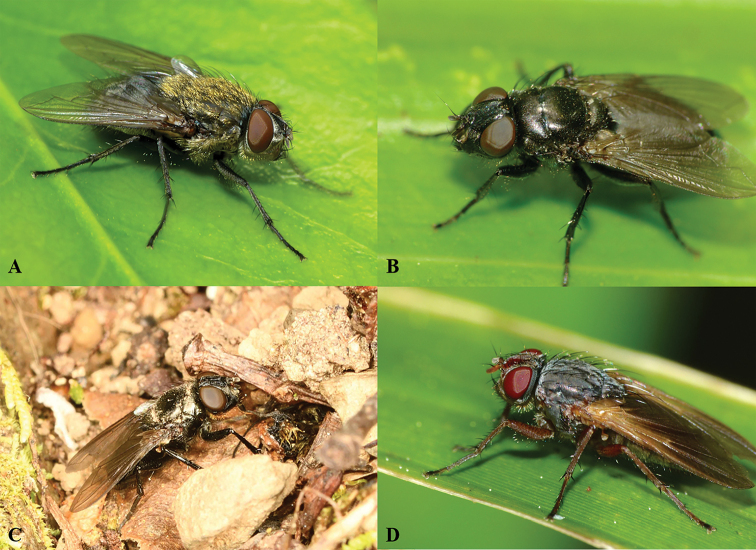
Diversity of the genus Pollenia. APollenia
pediculata Macquart [New Zealand] BPollenia
pernix (Hutton) [New Zealand] CPollenia
nr.
pernix [New Zealand] DPollenia
uniseta Dear [New Zealand]. Photographs: S. Kerr (A, B, D), S. Marshall (C).